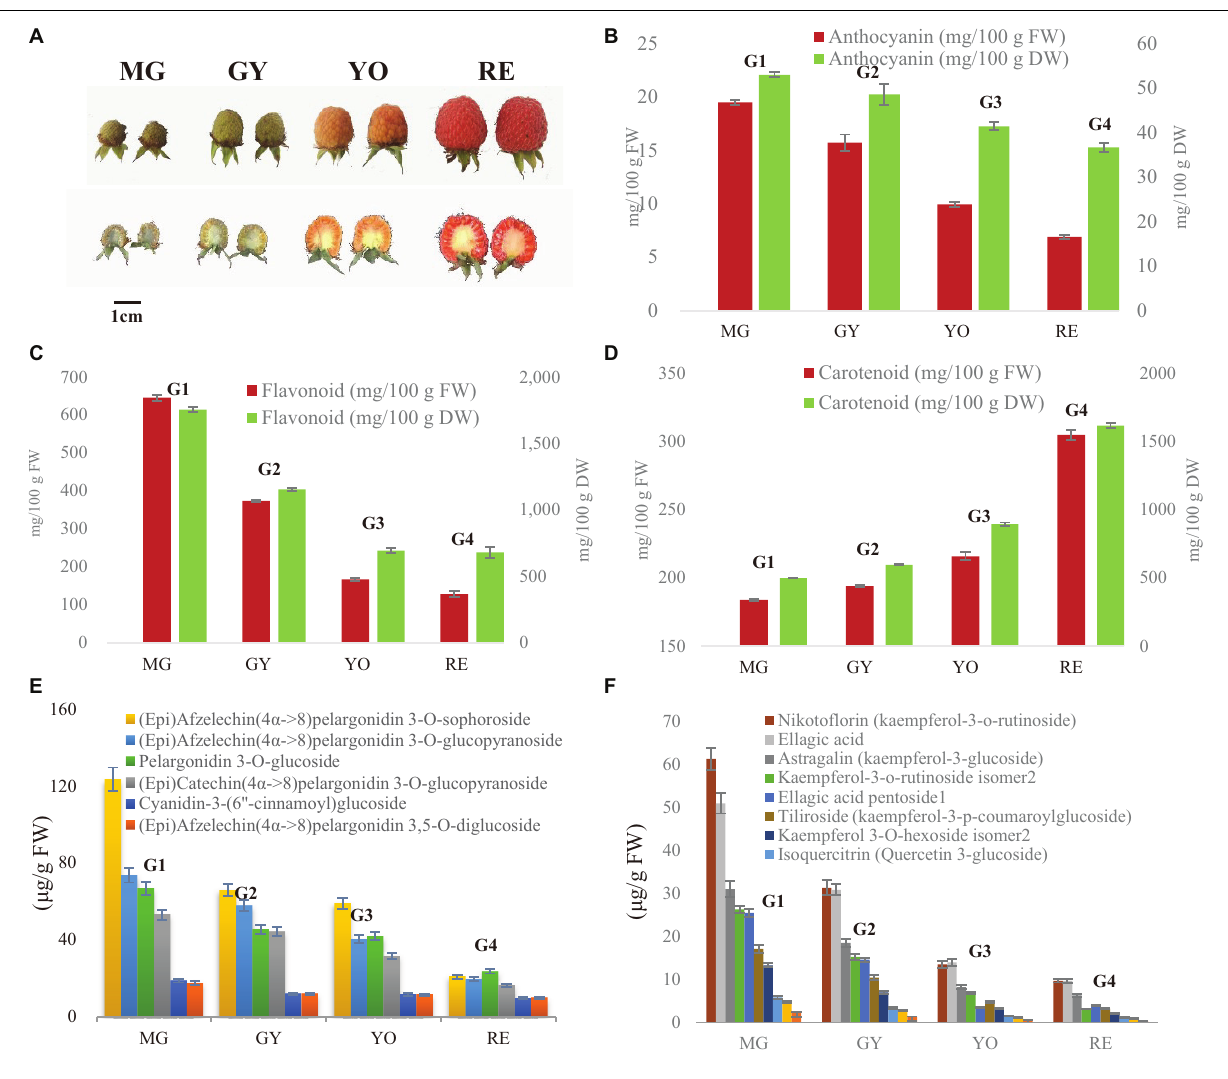
FIGURE 1 | Dynamic change of fruit appearance, anthocyanins and flavonoids during maturation in R. chingii . (A) Fruit appearance, (B) total carotenoid, (C) total anthocyanin (expressed as cyanidin 3-glucoside equivalents), (D) total flavonoids. The four typic phases of fruit maturation are MG, mature green; GY, green yellow; YO, yellow orange; RE, red. (E) Content of flavanol-anthocyanins. (F) Content of other flavonoids. Test of between-phases effects: significant ( P < 0.05); error bar indicates standard deviation (SD); homogeneous subsets in Duncan’s Multiple Range test: G1, G2, G3, and